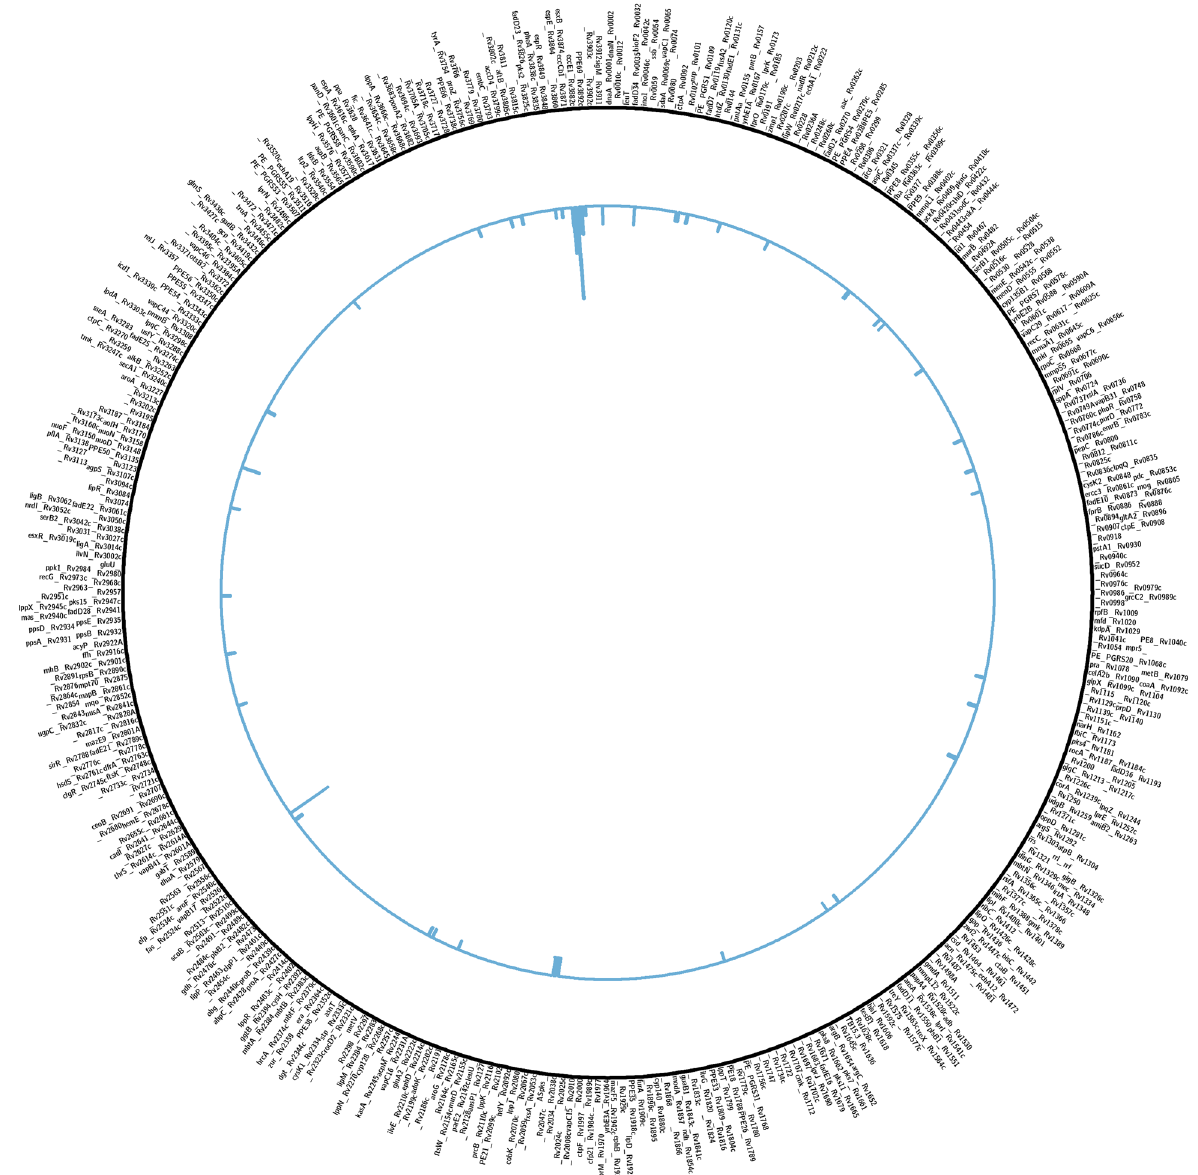
Fig. 4 Genome plot of M. tuberculosis H37Rv showing distribution of unique scars. The histogram shows number of unique scars found in the 48 scarred genes. Note the high incidence of scars in the ESX-1 gene